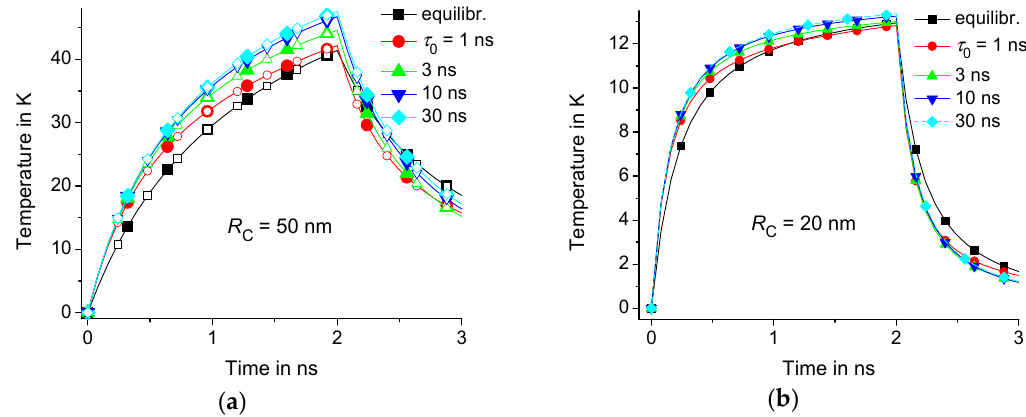
Figure 2. Time dependence of equilibrium solution (cid:101) T ( t , R C /2,0 ) is represented by the lines marked by